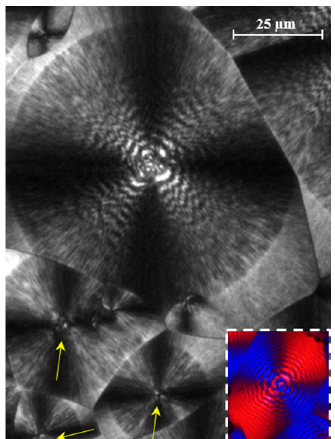
Figure 6. Optical micrograph of PDO spherulites formed during a non-isothermal crystallization from the melt state performed at a cooling rate of 20 °C/min. Yellow arrows point to spherulites formed at low temperatures. Inset shows a micrograph taken with a first-order red tint plate to determine the birefringence sign.